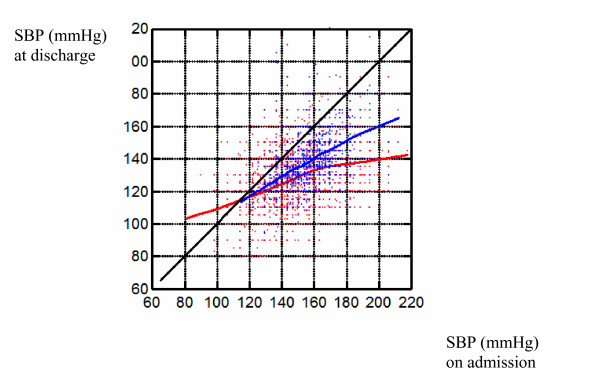
Change of systolic blood pressure from admission (abscissa) to discharge (ordinate) in inpatients and outpatients. LOWESS regression. Inpatients are represented by the red regression line, the outpatient values by the blue regression line. Values are corrected for reliability (i.e., for regression-to-the-mean effects).